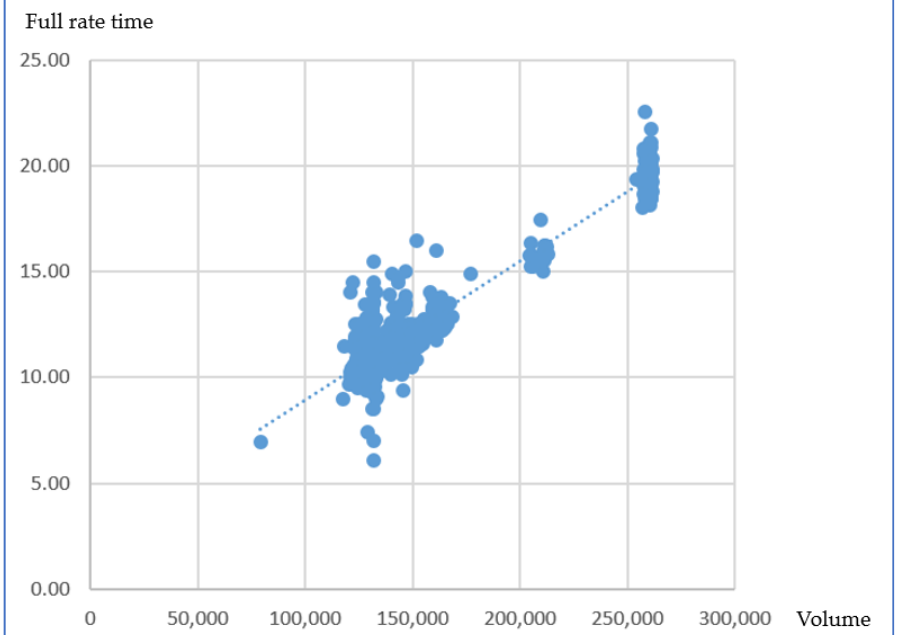
Figure 4. Regression analysis of cargo volume and full rate time.